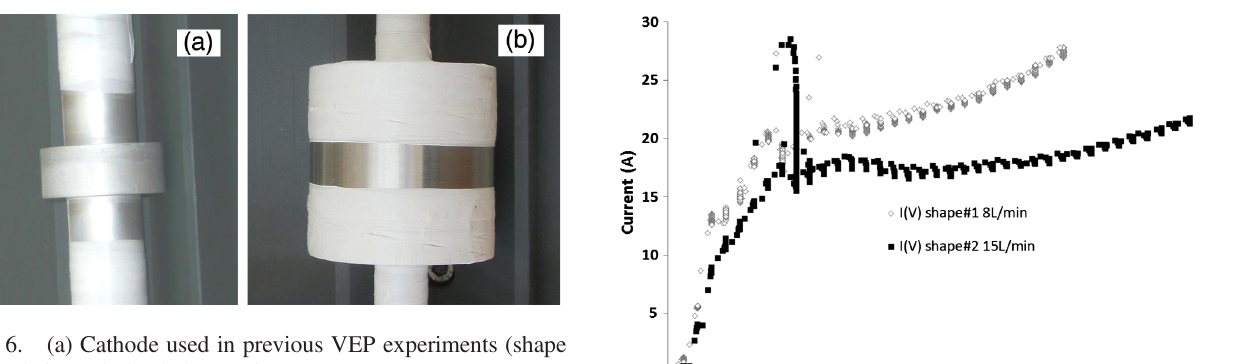
FIG. 6. (a) Cathode used in previous VEP experiments (shape #1) and (b) optimized shape (shape #2).